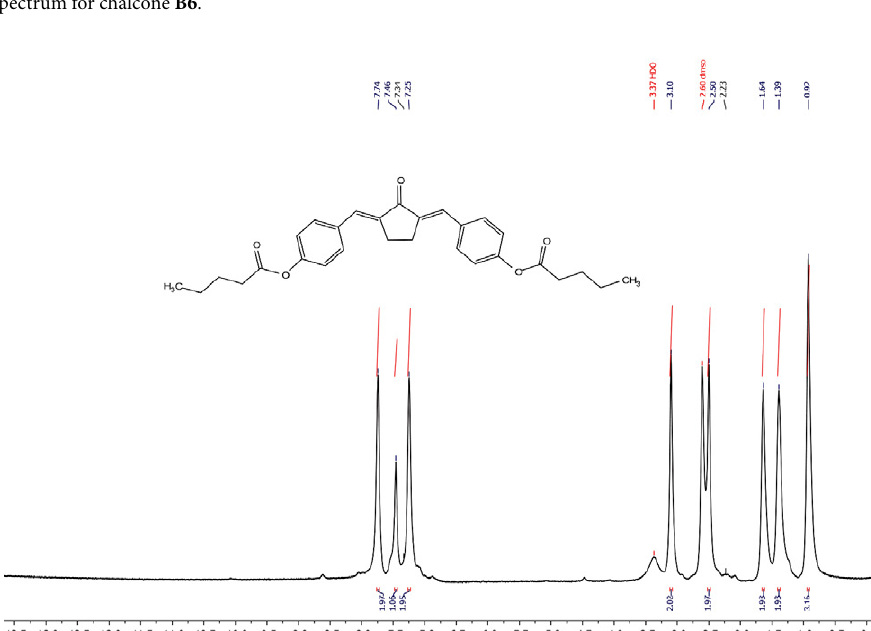
Figure 4: FT IR spectrum for chalcone B6 .